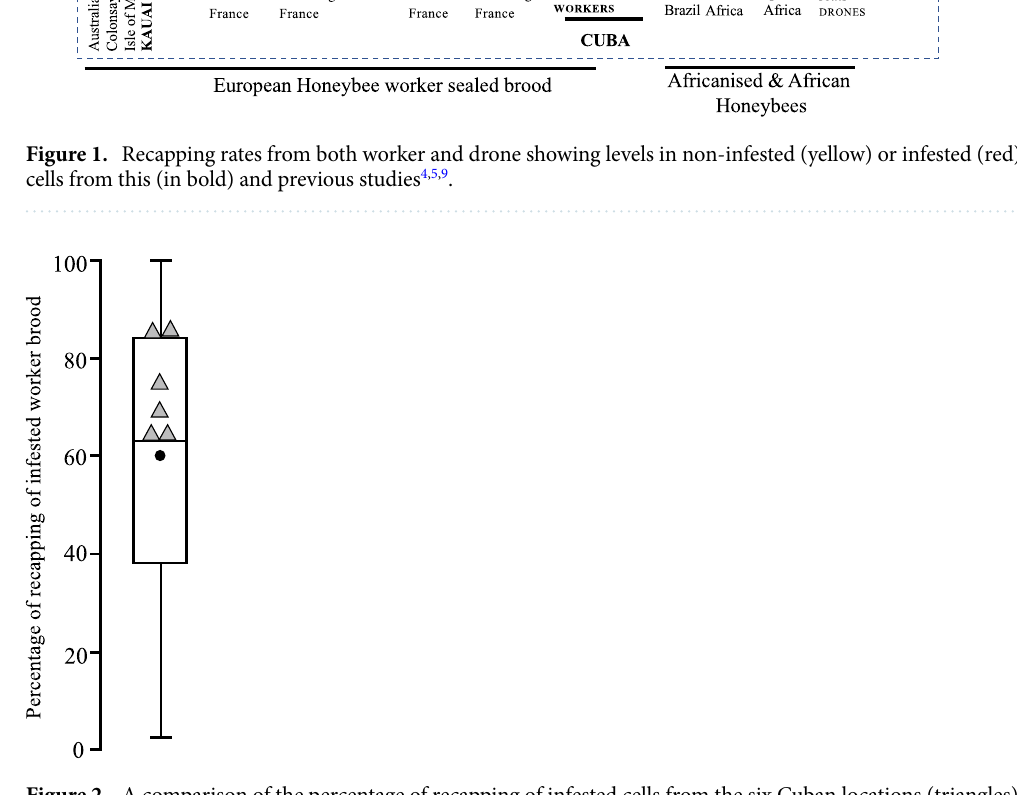
Figure 2. A comparison of the percentage of recapping of infested cells from the six Cuban locations (triangles) in comparison with the 101 data points from the other resistant A. mellifera colonies studied around the world according to 7 is shown as a box